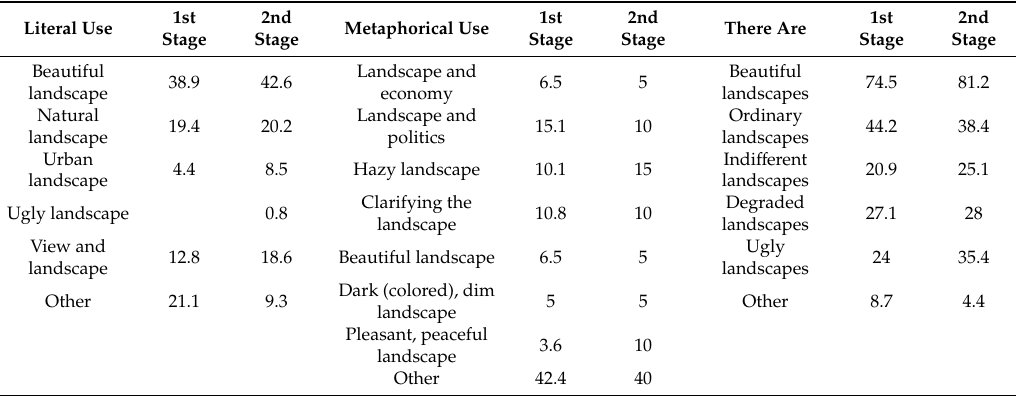
Table 2. Literal and metaphorical uses of the word landscape by Greek engineering students (1st and 2nd research